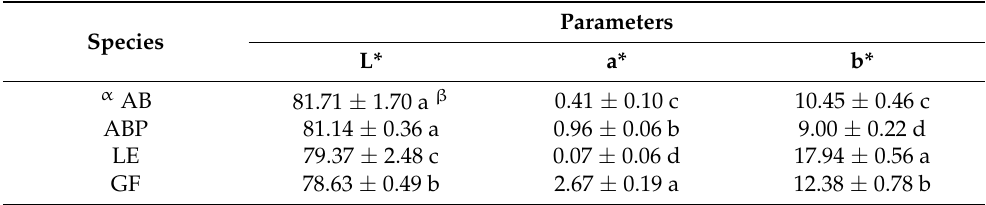
Table 2. Instrumental color parameters (L*, a* and b*) of the freeze-dried mushroom samples under evaluation.